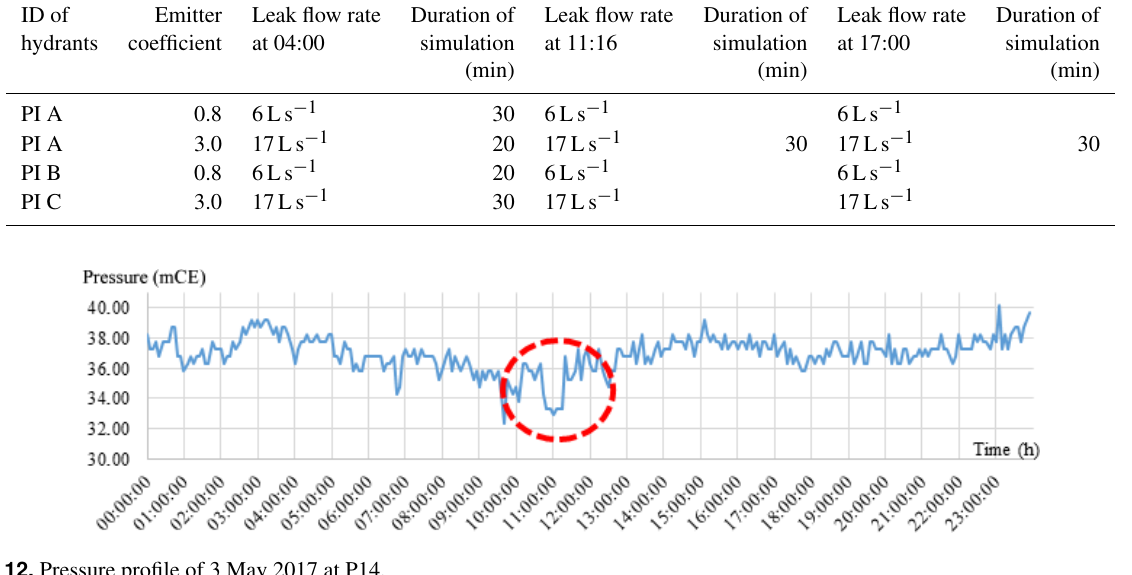
Table 3. Leak information in the study area. All times are local time (UTC + 1).